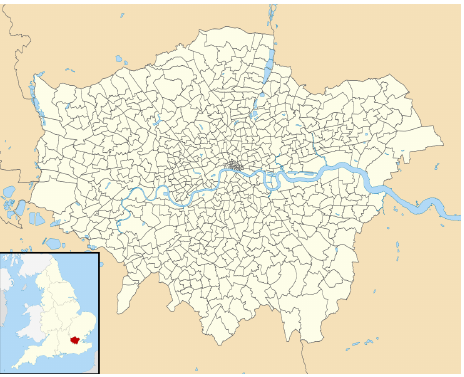
Figure 3. Map of the ward divisions of the Greater London area [30].